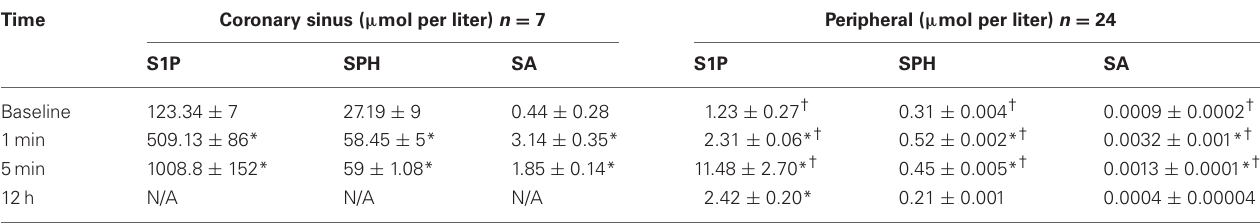
Table 2 | Plasma levels of sphingolipids in coronary sinus and peripheral blood in patients who underwent PCI. Time Coronary sinus ( µ mol per liter) n = 7 Peripheral ( µ mol per liter) n = 24